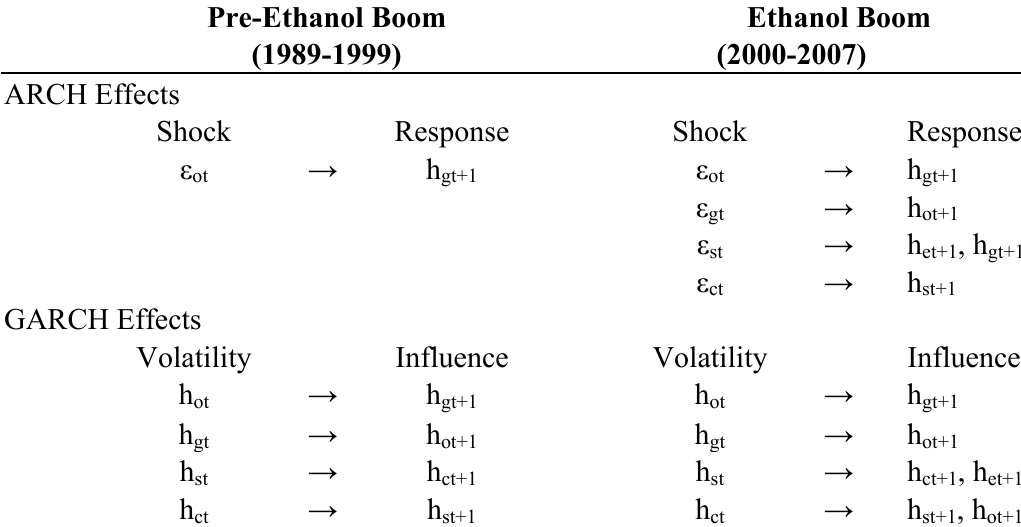
Table 6. Impacts of the MGARCH Model a